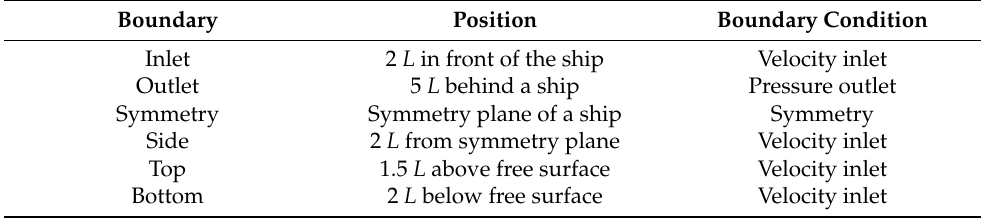
Table 1. Configuration of the numerical